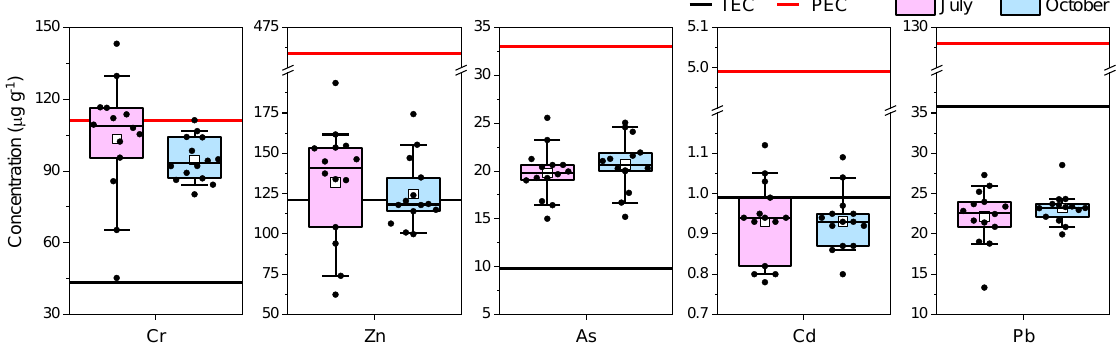
Figure 8. Box plots of the potentially harmful element (Cr, Zn, As, Cd, and Pb) concentration in the Podu Iloaiei Lake sediment, along with the threshold effect concentration (TEC) and probable effect concentration (PEC)) (thin black line — median; white square — mean; box — 25 – 75% percentiles; length of the whiskers plot — 10% and 90% of observed concentrations).